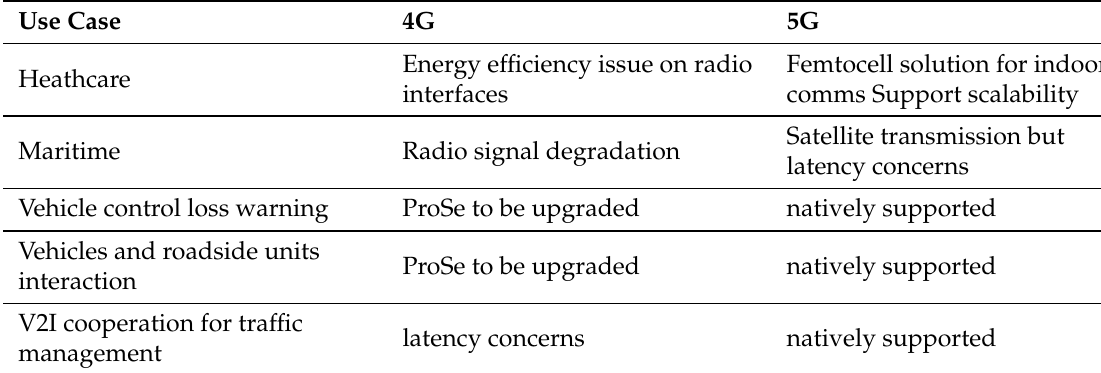
Table 1. 4G and 5G technology challenges in